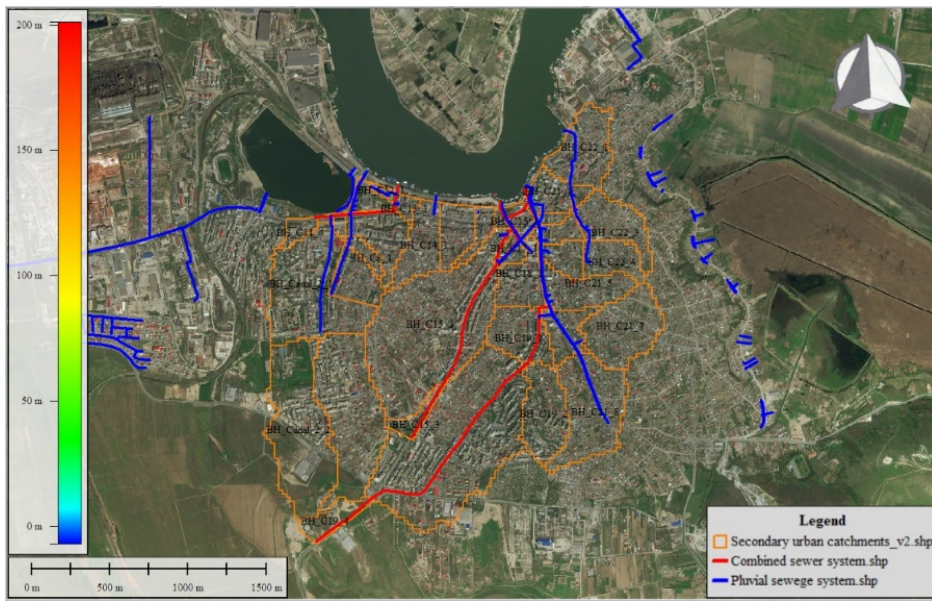
Figure 11. Sub-basins and main sewage system.